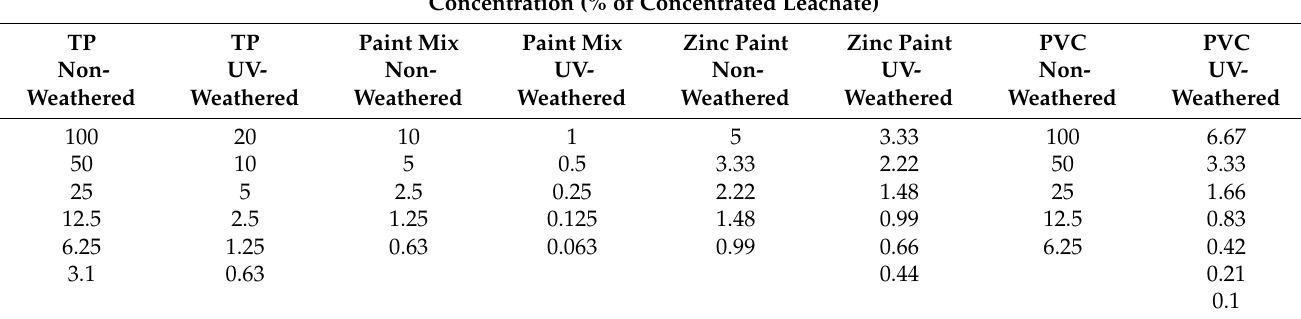
Table 1. The tested concentrations of the definitive tests expressed as the percentage of the concentrated leachate (% of concentrated leachate). Non-weathered refers to microparticles not exposed to UV irradiation, while UV-weathered refers to microparticles exposed to UV-C. The tested concentrations of the weathered microparticle leachates were lower than the non-weathered one, as the range-finding tests demonstrated higher toxicity of these to the